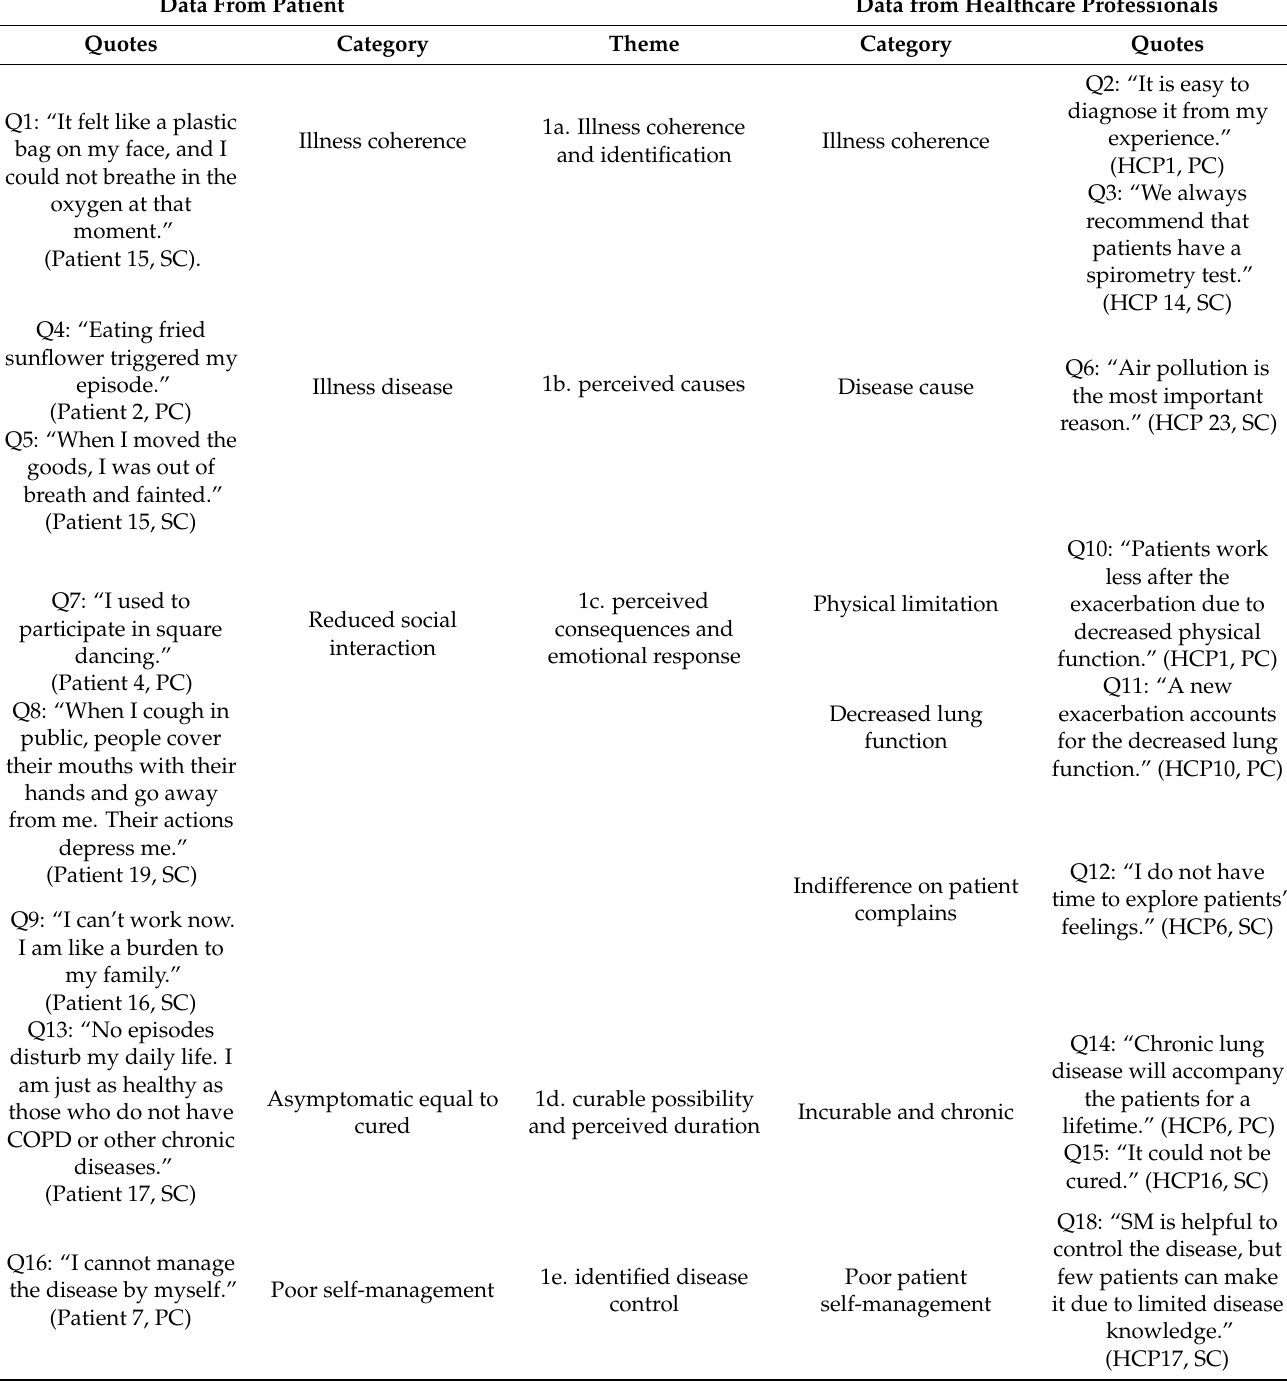
Table 5. Themes presented from patients and healthcare professionals (HCPs) of illness perceptions and self-management (SM) skills with